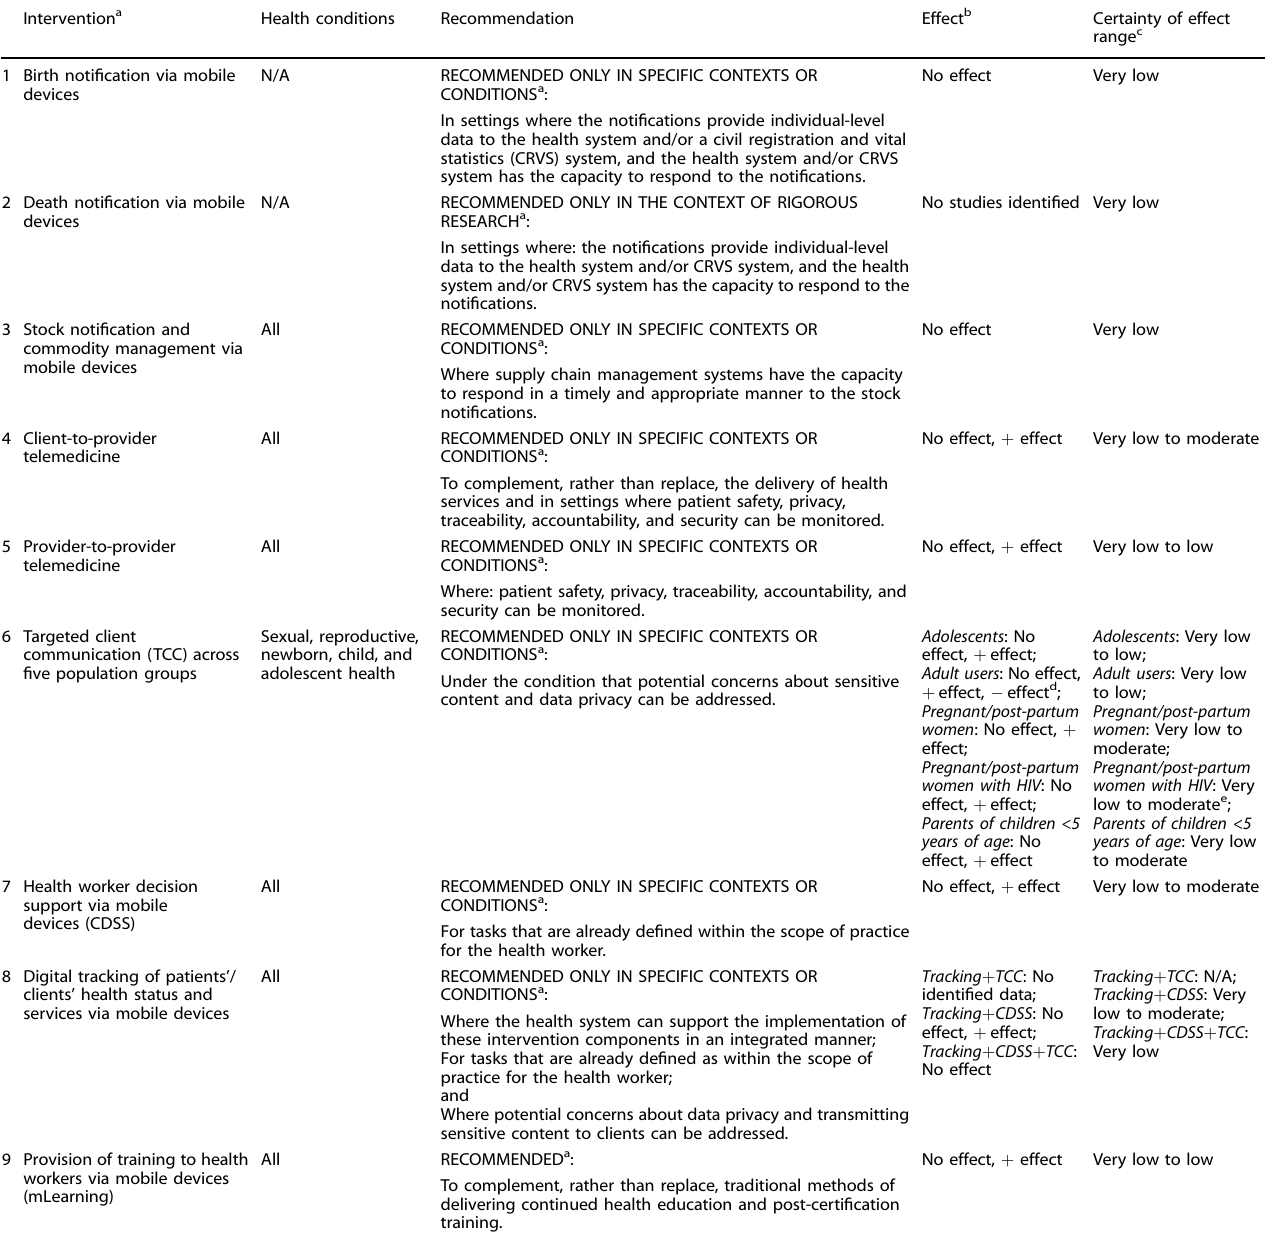
Table 1. Summary of WHO Guideline: recommendations on digital interventions for health system